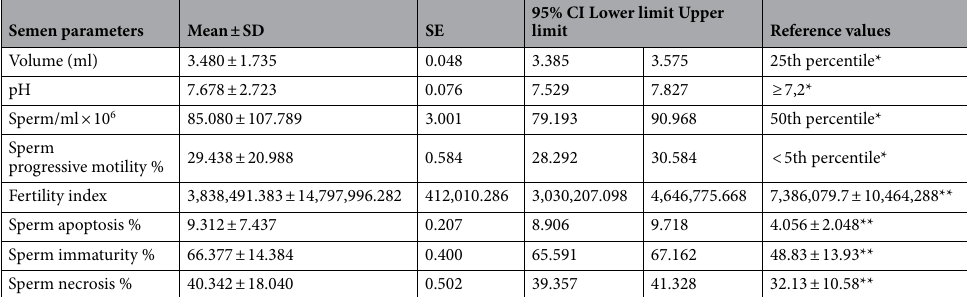
Table 2. Semen parameters of the patients’ sample (n = 1294) and the inferential estimations of these measures (95% CI). Sperm characteristics were evaluated by light microscopy (sperm/ml × 10 6 , sperm progressive motility) and by TEM (fertility index, sperm apoptosis, immaturity, necrosis). * 12 ; ** 33 .